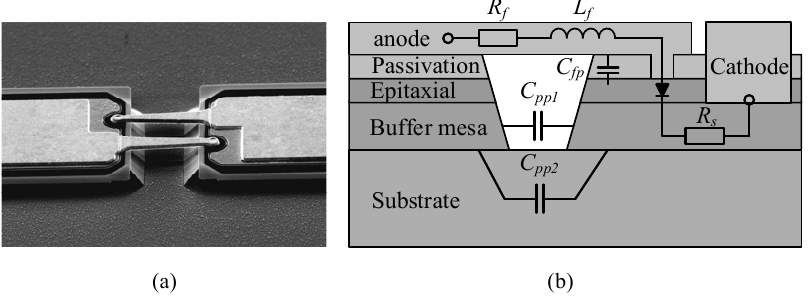
Figure 1. ( a ) Microphotograph of planar Schottky diode. ( b ) Equivalent parasitic